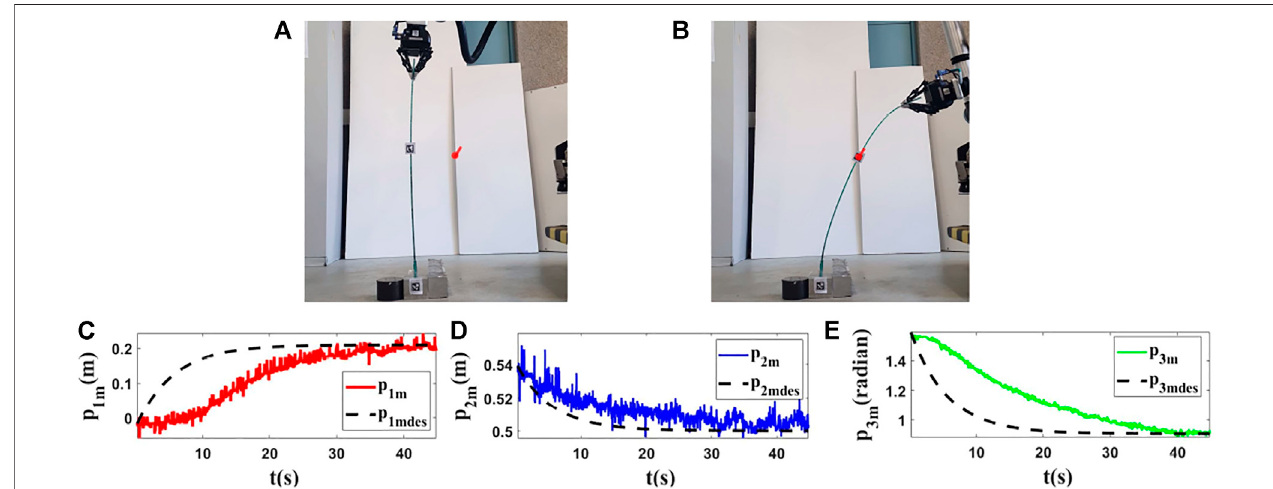
FIGURE13| Experiment4.Firstrow: (A) and (B) aretheinitialand fi nalshapeoftheobject,respectively.Thedesiredstateof m isshownasaredcirclewithasmall line segment. We assume that M 0 is [ − 0.019,0.539,1.578] T and we want to move it to M fdes = [0.209,0.500,0.908] T . The fi nal state of the controlled point is M f = [0.202,0.503,0.908] T . Second row: (C – E) are the states of the controlled point in the fourth experiment with respect to their desired trajectories.